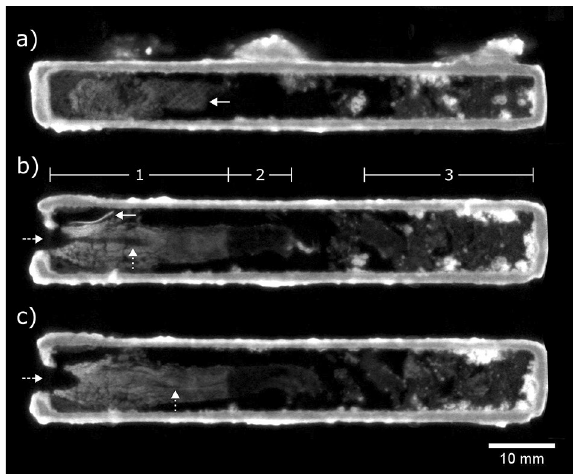
Figure 2. EA49144 neutron CT slices. ( a ) Side-view, slice 3.2 mm from right side of box (solid arrow: textile in plug). Top-view slices at ( b ) 4.0 mm and ( c ) 5.3 mm from base of box, with internal regions ( 1 ) plaster plug ( 2 ) weakly-attenuating end of plug, ( 3 ) fragments. Solid arrow: unidentified object adjacent to plug; dashed arrows: drilled hole in plug; dotted arrows: narrow void extending through plug.